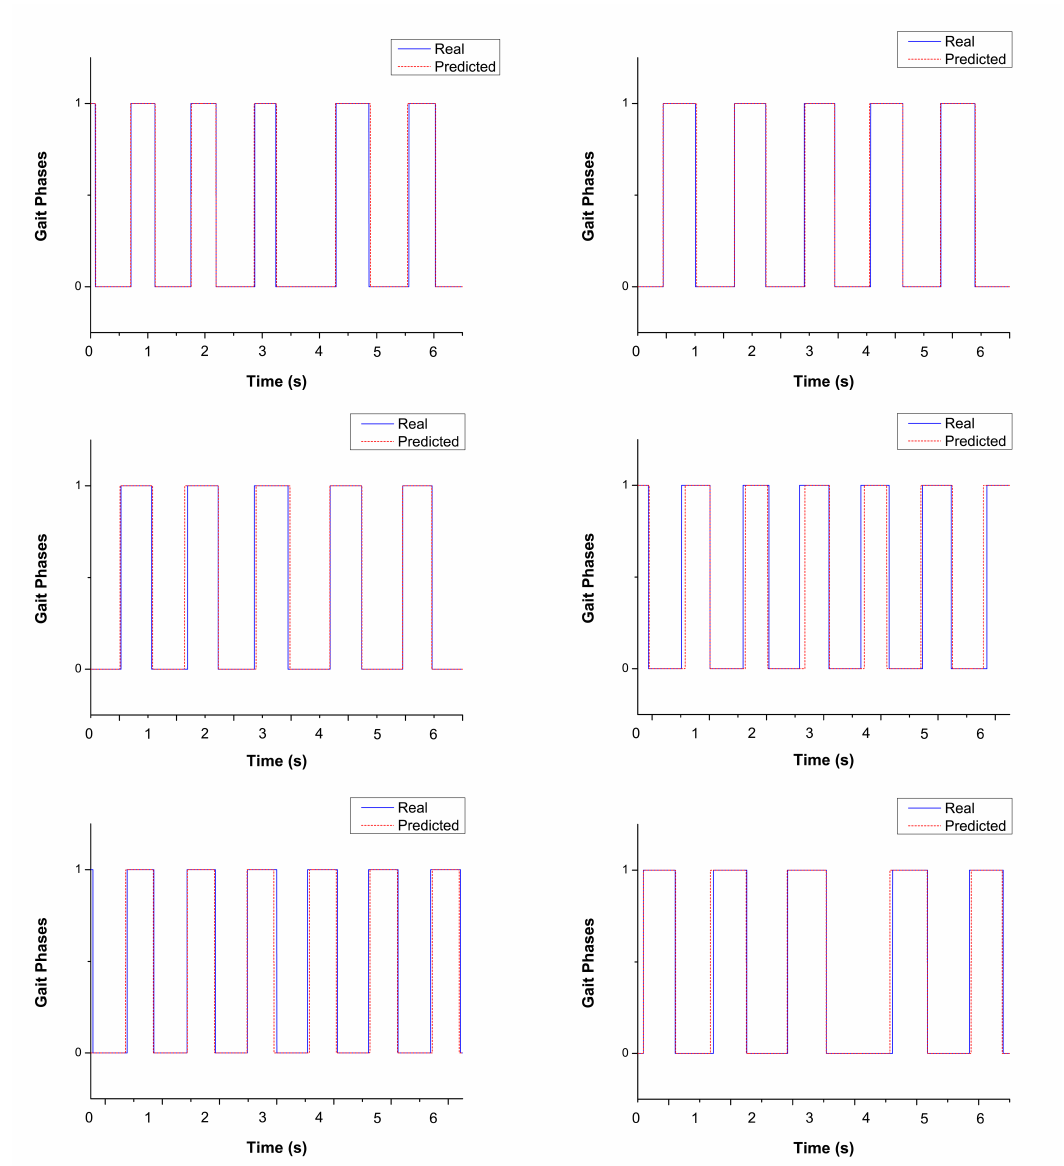
Figure 7. Examples of TO and HS predictions on six random